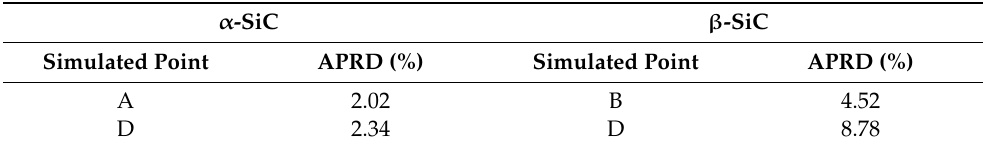
Table 3. Average percent relative deviation (APRD) between simulated values of temperature and thermocouple readings from heating experiments.